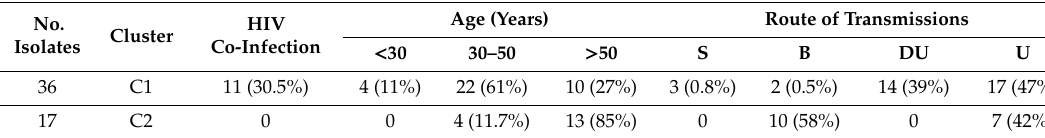
Table 1. Demographic and clinical features of HCV-4d infected patients studied. S: Sexual relations, B: Blood, DU: Drug use, U: Unknown.